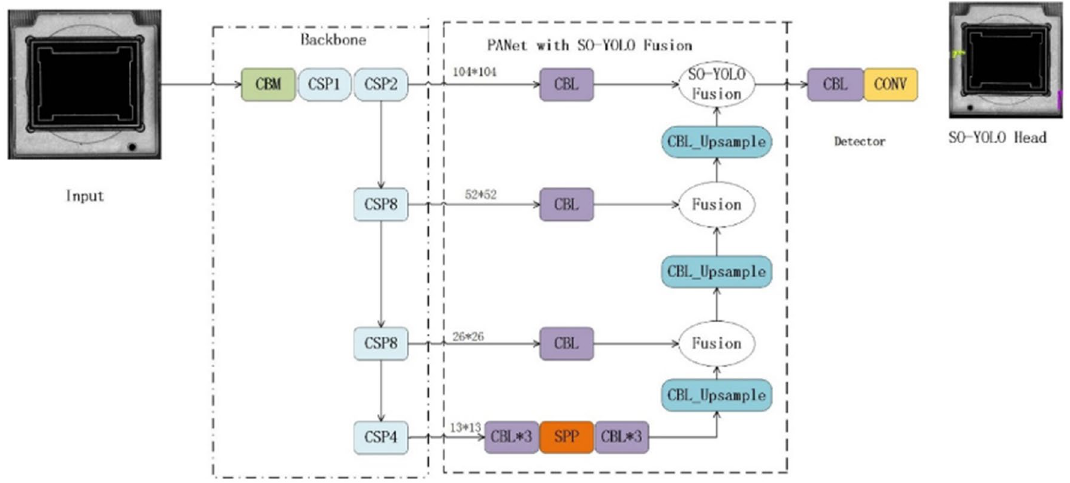
Figure 3. The architecture of the proposed